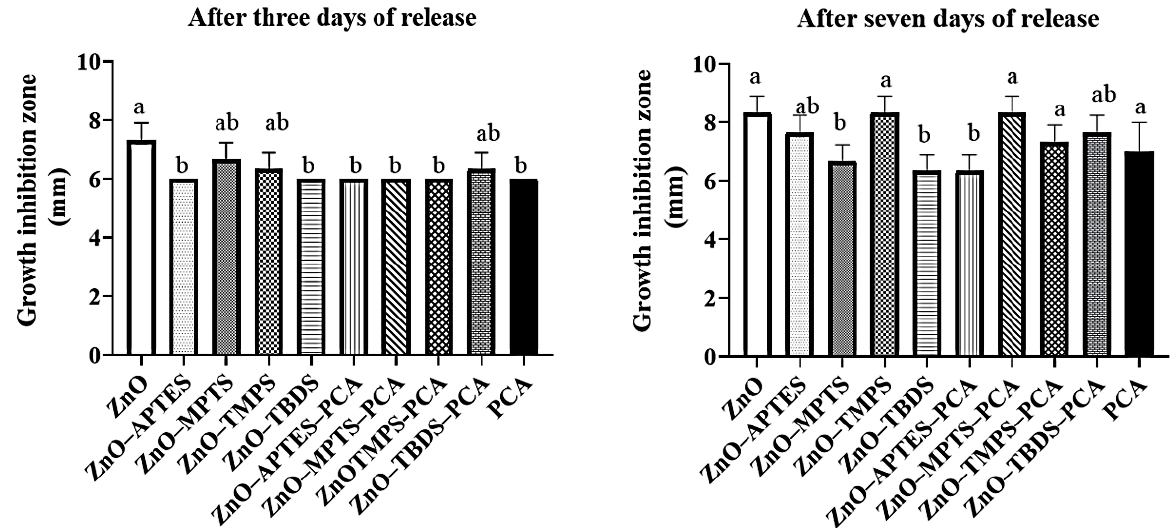
Figure 9. Antimicrobial activity of the solutions (supernatants) obtained after three and seven days of incubation of the tested materials at 37 °C in the PBS. Columns labeled with different letters (a, b) had significantly different average values ( p ≤ 0.05). Materials marked by the same letter (for instance, “a”) displayed no significant differences. Materials marked with different letters (for instance, “a” for one material and “b” for another material) displayed significant differences.